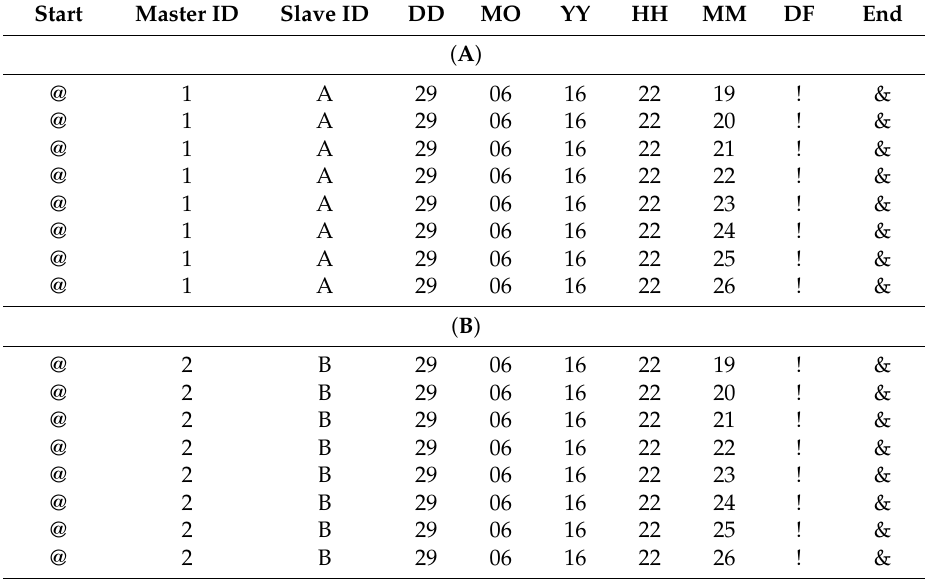
Data collected by the data transmitter breadboard. Start : “@” starts recording information. Master ID : Device identification “1, 2”. Slave ID : Device identification “A, B”. DD : Recording day. MO : Recording month. YY : Recording year. HH : Recording hour. MM : Recording minutes. DF : “!” dummy field. End : “&” end of the